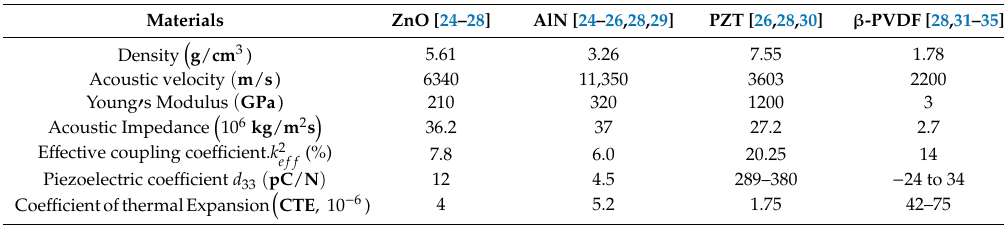
Table 1. Comparison of piezoelectric materials.